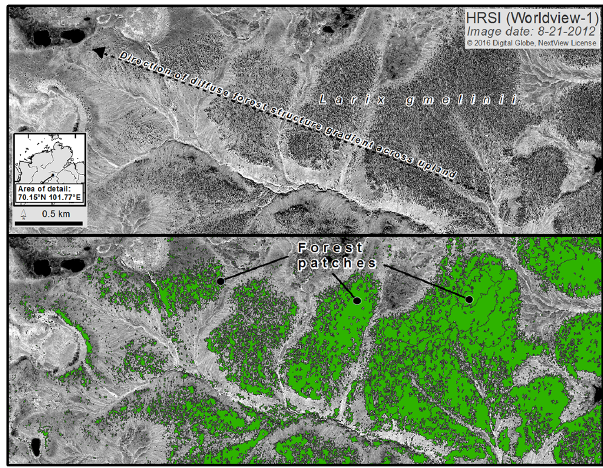
Figure 2. A representative example of forest patches showing a diffuse forest structure gradient of Larix gmelinii across an up- land site delineated from HRSI. The top image shows a subset of a Worldview-1 panchromatic image from 21 August 2012 in one of the forest patch mapping sites. The bottom image shows the same subset with forest patches overlaid (green).